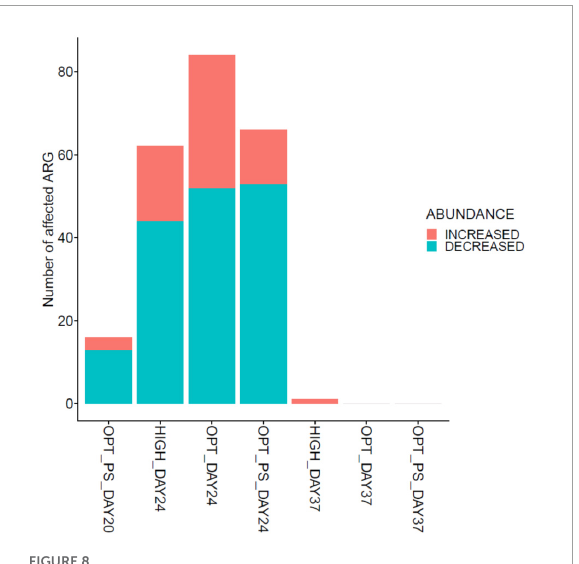
FIGURE8 Impact of synbiotic and/or enrofloxacin application on differential abundances of ARGs. The bar plot shows the number of significantly affected ARGs (either increased or decreased) based on differential abundance analysis in broiler chicken cecum